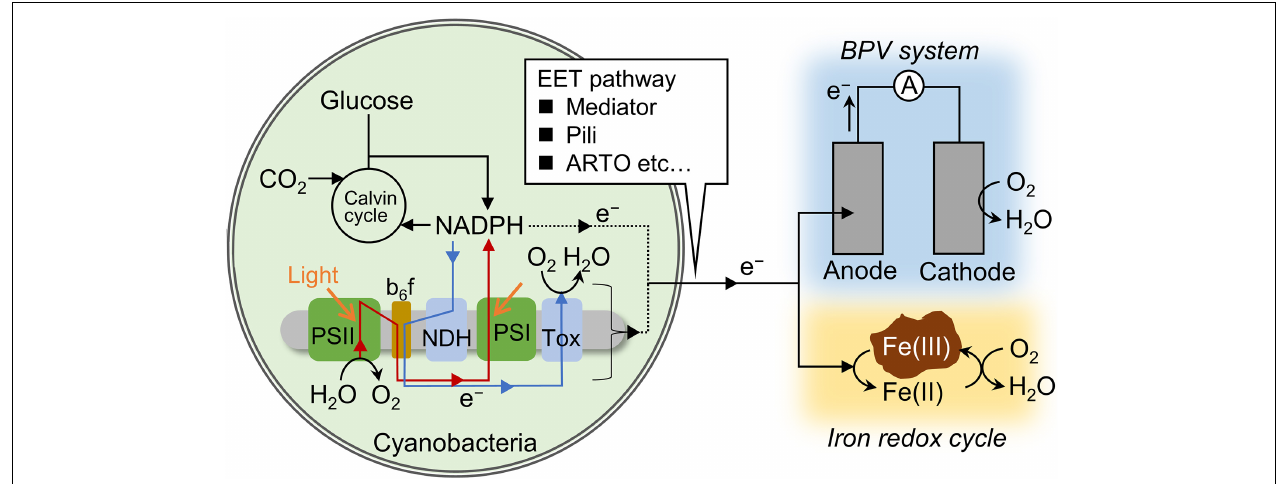
FIGURE 1 | Schematic of the electron flux pathways related to anodic current generation and iron reduction. Red and blue arrows indicate photosynthetic and respiratory electron transfer chain. In photosynthetic electron transfer chain, electrons are transported from photosystem (PS) II to I via the interchain components, including plastoquinone, the cytochrome b 6 / f complex, and plastocyanin (or cytochrome c ). In respiratory electron transfer chain, electrons are transported from NAD(P)H dehydrogenase (NDH) or succinate dehydrogenase to terminal oxidases (Tox) via the interchain components. Redox mediators, Type IV pili, and alternate respiratory terminal oxidase (ARTO) are suggested to function at the step of extracellular electron transfer